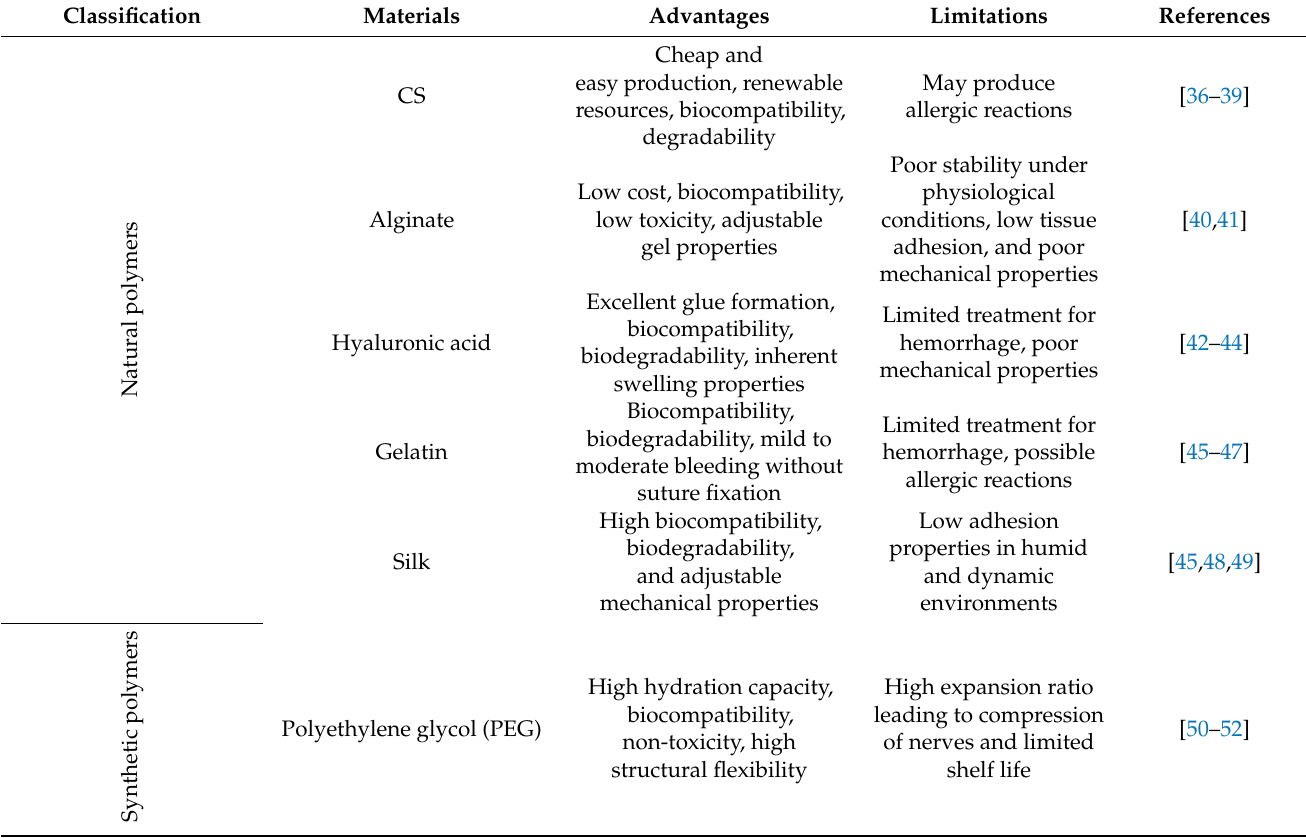
Table 1. Advantages and disadvantages of common polymers as hemostatic hydrogels. Classification